Question: Generate an informative caption for the figure above.
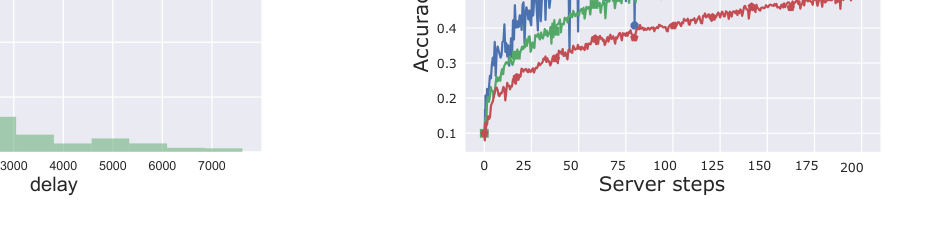
Answer: Accuracy on validation dataset on central server, for CIFAR-10 classification task.